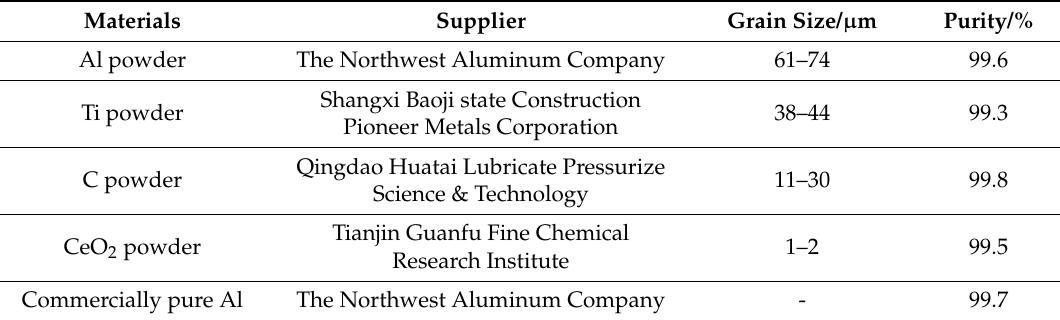
Table 1. Characteristics of